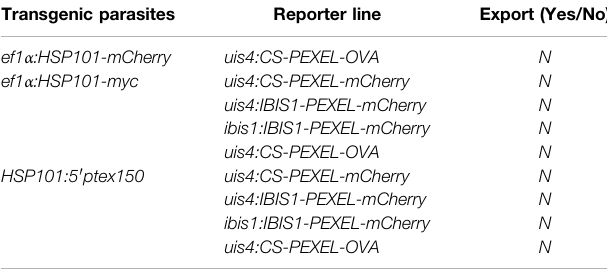
TABLE 1 | Export ability of reporter lines in transgenic HSP101-expressing liver